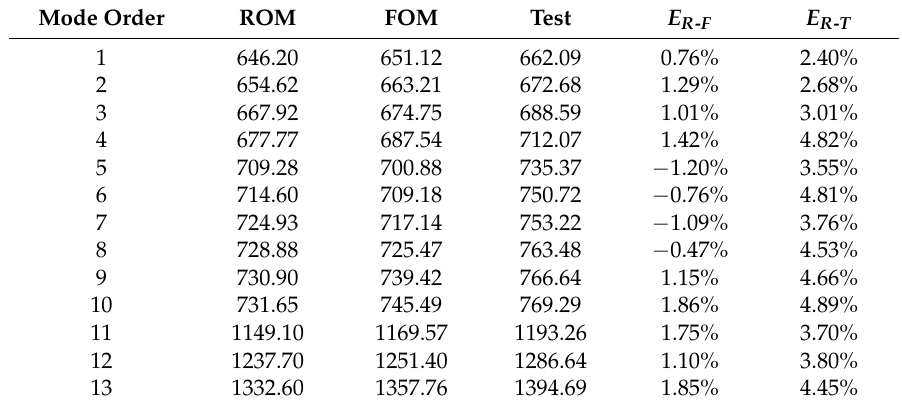
Table 3. Natural frequencies obtained from the ROM, full ‐ order model (FOM), and the test (Hz). Mode Order ROM FOM Test E R - F E R - T